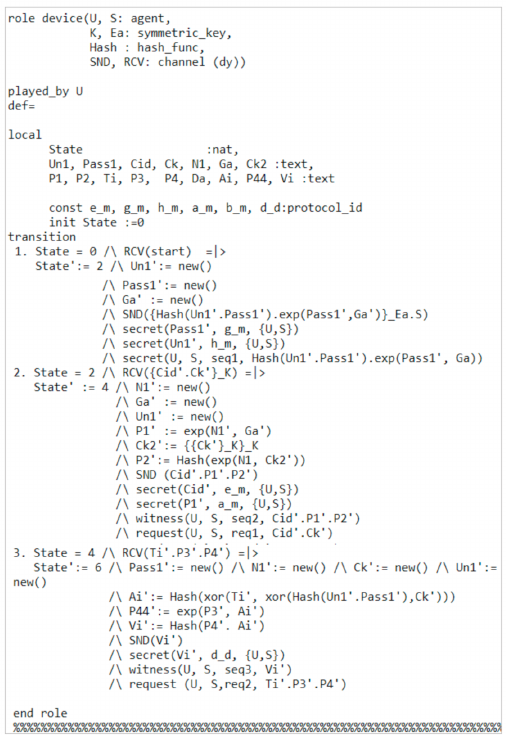
Figure 4. Role specification for IoT devices.